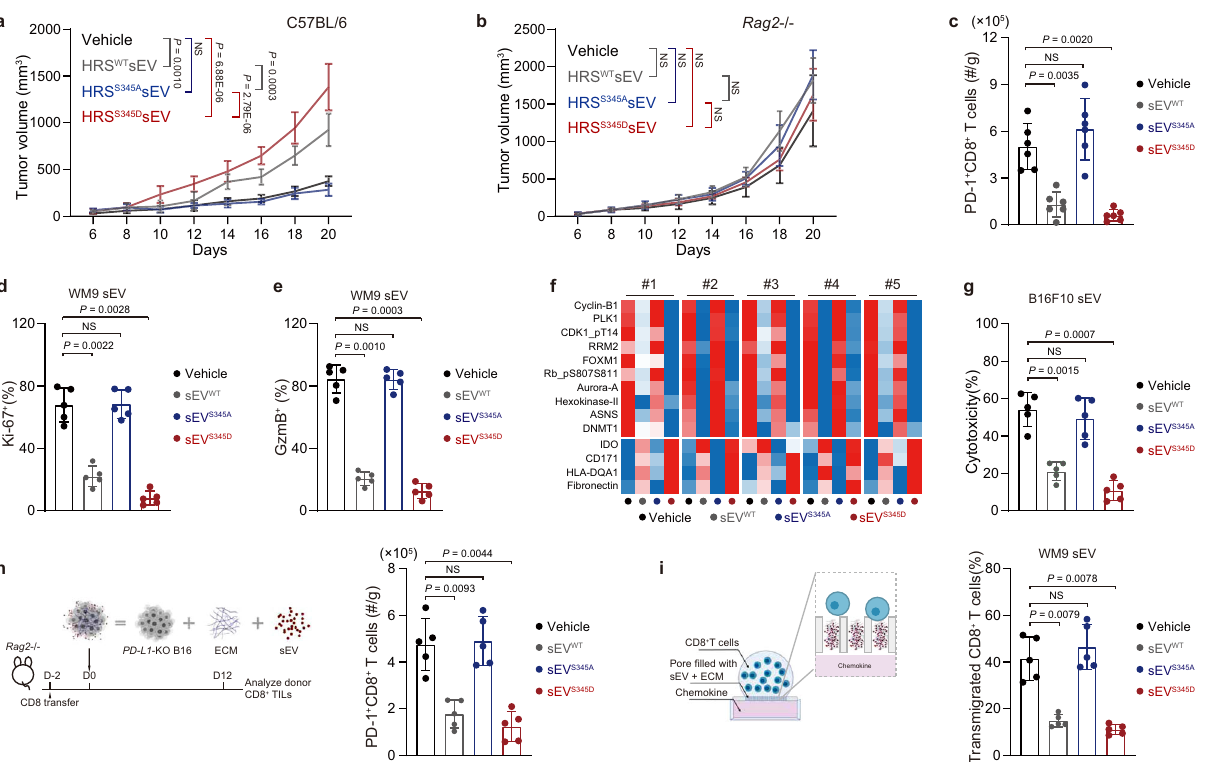
Fig. 4 HRS phosphorylation enhances the suppressive effect of sEV on CD8 + T cells. a – b Growth of PD-L1 -KO B16F10 tumors in C57BL/6 and Rag2 − / − mice with indicated sEV treatments ( n = 6 for each group). c Scatter-bar graphs indicating the number of intratumor PD-1 + CD8 + TILs (normalized to tumor weights) in B16F10 tumors expressing HRS mutants in ( a ). d , e Percentages of Ki-67 + and Granzyme B + cells in human CD8 + T cells treated with indicated sEVs ( n = 5). f Heatmap of RPPA data showing the signi fi cantly changed proteins in peripheral CD8 + cells with indicated sEVs treatment. Proteins considered signi fi cantly changed between vehicle control and sEV WT treatment group are described in Supplementary Fig. 9d. g Cytotoxicity elicited by mouse splenocytes with or without exposure to indicated B16F10 cell-derived sEVs ( n = 5). See METHODS for details. h Schema for sEV co- xenograft system (left) (See details in METHODS ). CD8 + T cells were transferred into Rag2 − / − mice 2 days before tumor injection. PD-L1 -KO B16F10 cells were mixed with Matrigel (ECM) and sEVs from B16F10 cells and subcutaneously inject into the mice. The number of PD-1 + CD8 + T cells in the co-grafted tumors was determined on Day 12 ( n = 5) (right). i Schema for the chemotaxis assay to access CD8 + T cells migration with sEVs and fi bronectin (ECM) (left) (See the details in METHODS ). Percentages of transmigrated human CD8 + T cells stimulated with CXCL9 (100 ng/mL) in chemotaxis assay. 3- μ m size pores were blocked by fi bronectin with vehicle or indicated WM9 cell-derived sEVs ( n = 5) (right). The experiments were repeated three ( a – c , h ) and fi ve ( d , e , g , i ) times independently with similar results obtained. Data represent mean ± s.d. Statistical analyses were performed using one-way ANOVA ( c – e , g – i ) or two-way ANOVA ( a , b ). Tukey ’ s test was used following ANOVA. Source data are provided as a Source Data fi